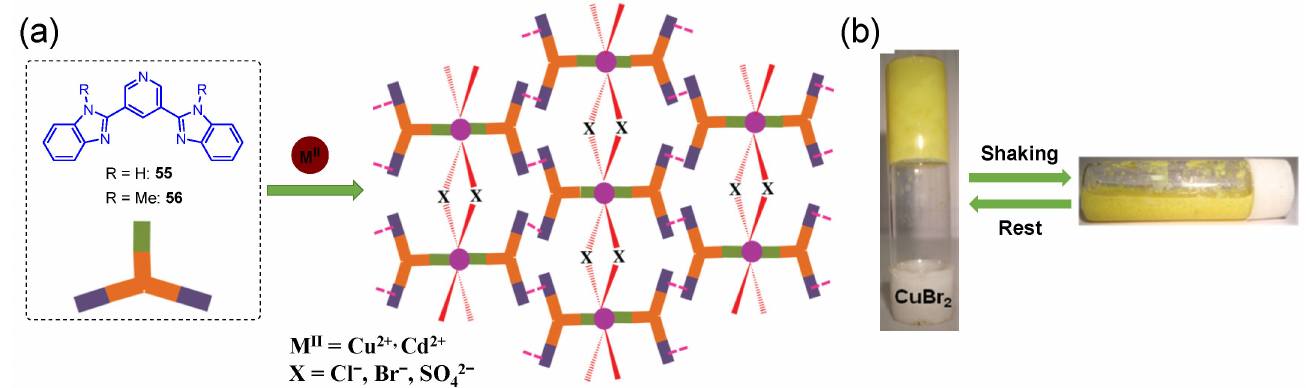
Figure 25. ( a ) Molecular structure of pyridine-3,5-bis(benzimidazole-2-yl) ligands 55 and 56 , and proposed model of the self-aggregation of 55 and metal halides (X). ( b ) Illustration for mechano- responsive nature of 55 -CuBr 2 gel. Reprinted with permission from Ref. [92]. Copyright (2012), American Chemical